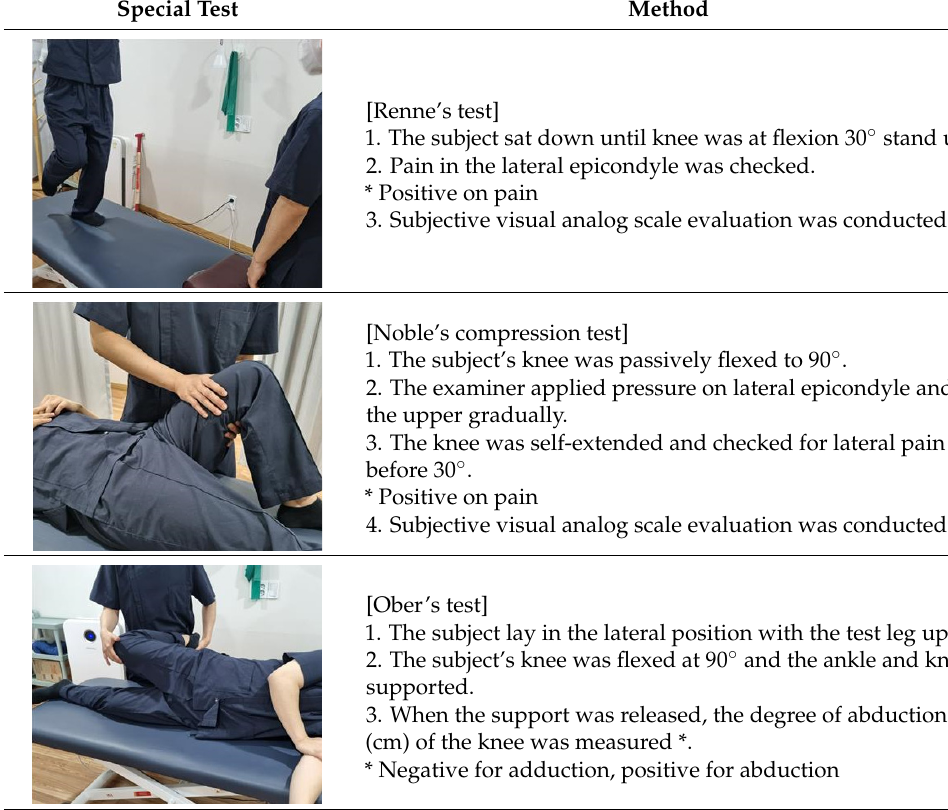
Table 2. Special test method for evaluation of iliotibial band friction syndrome.